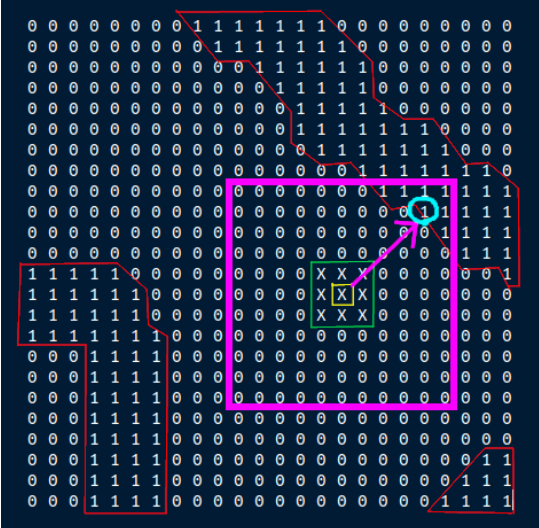
Figure 4. Road-finding algorithm on example Mask R-CNN output.